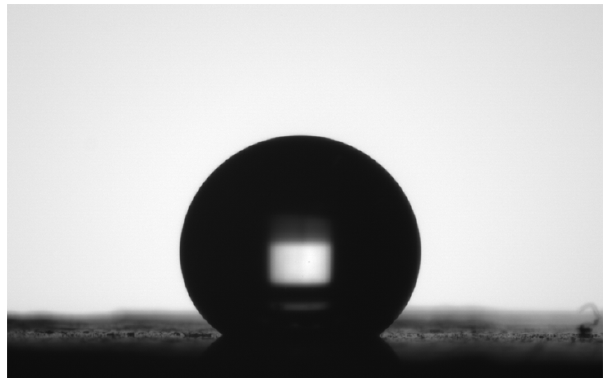
Figure 7. Contact angle of RGO/Fe 3 O 4 nanocomposites.